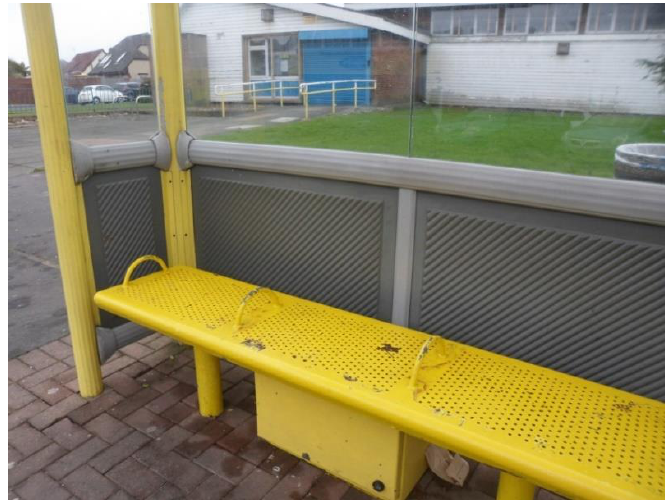
Figure 16. Example of a bus bench promoting respect and social inclusion (P23) (Bus stop, Liverpool).